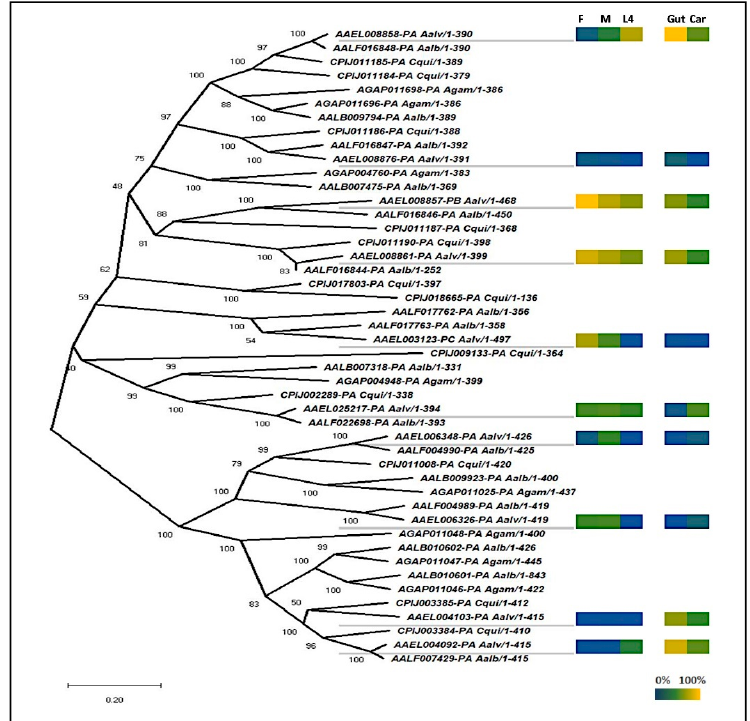
Figure 1. Phylogenetic tree of mosquito dsRNases and expression heat map of representative Ae. aegypti dsRNases. The neighbor-joining phylogenetic tree was produced in MEGA X from Clustal-Omega alignments’ mosquito homologue proteins with scale bar indicating genetic distance. F, M, and L4 represent male, female, and fourth instar larvae, respectively. Gut and Car represent gut and carcass. Expression is shown by a color scale where 100% is equal to the highest observed expression and 0% is the limit of detection from four biological replicates per sample type.